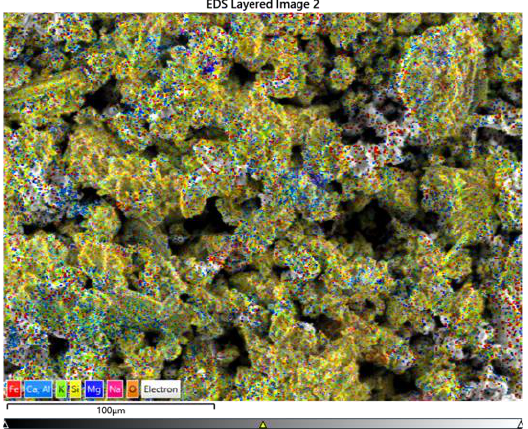
Figure 4. Sample EDS distribution maps (for sample C2). The masses of the green and fired samples are shown in the Figure 5. Up to 17%